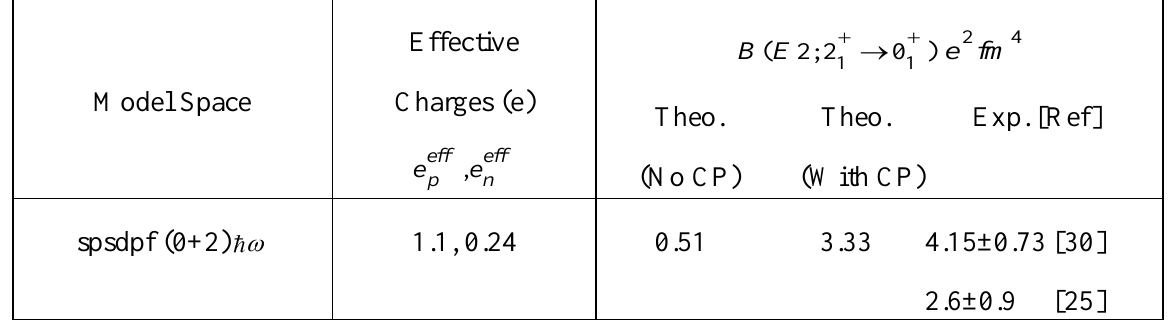
Table 2: The calculated effective charges and B(E2) values of 16 C compared with the experimental